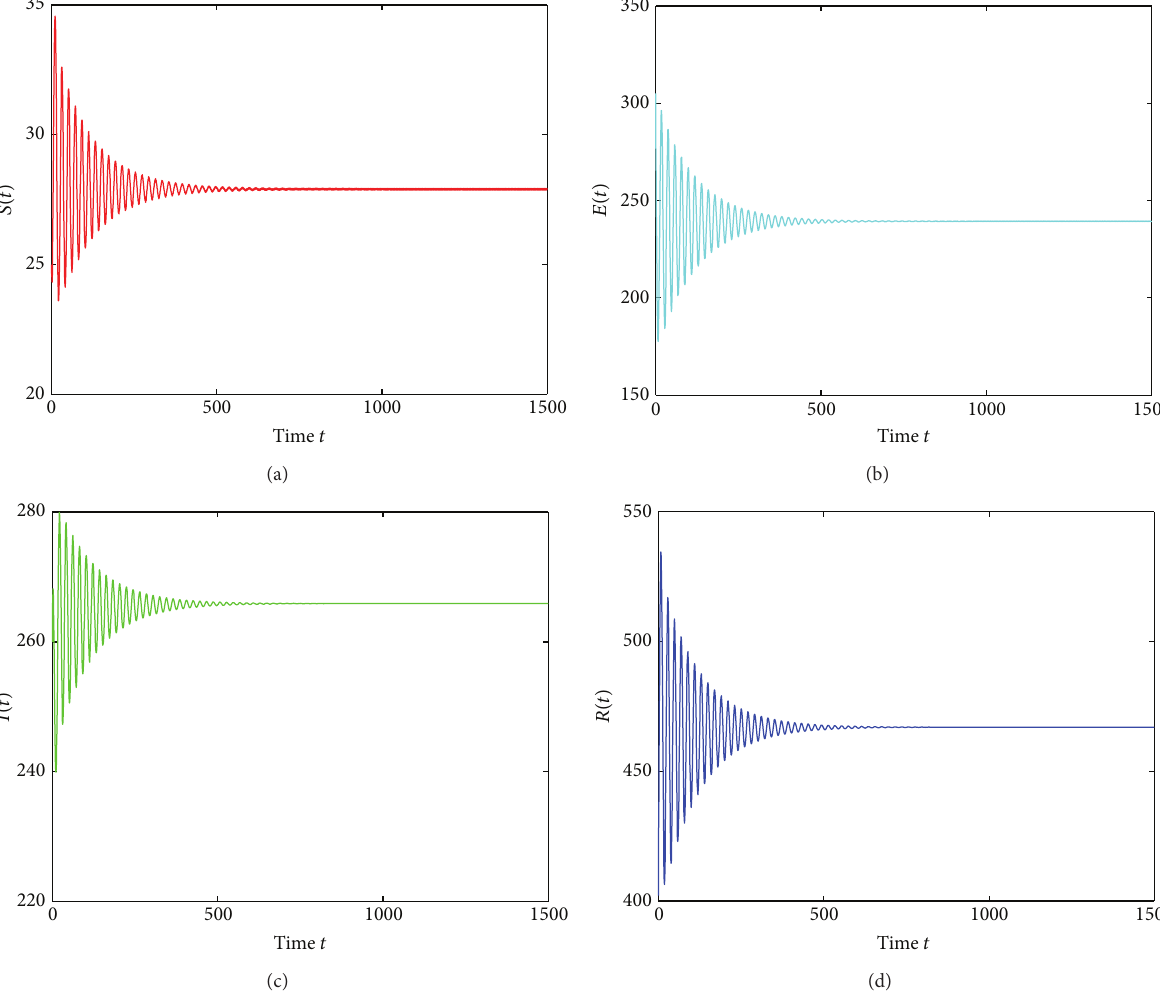
Figure 13: The track of the states 𝑆 , 𝐸 , 𝐼 , and 𝑅 for 𝜏 1 = 7.2000 < 7.8533 = 𝜏 ∗ 1 and 𝜏 ∗ 2 = 3